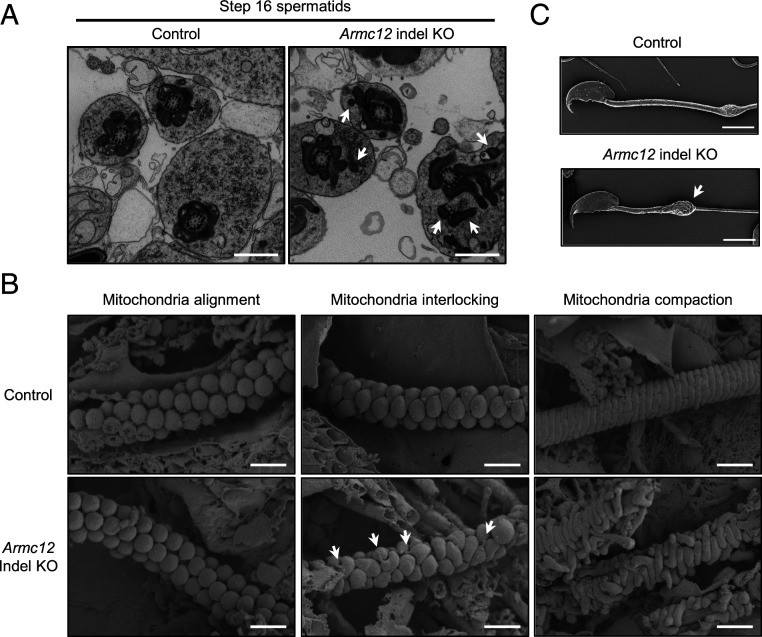
ARMC12 is essential for proper mitochondrial elongation and subsequent coiling along the flagellum during spermiogenesis. (A) Ultrastructural images of step 16 spermatids analyzed by TEM. Arrows indicate aberrant location of sperm mitochondria. (Scale bars, 1.0 μm.) (B) Development of mitochondrial sheath during spermiogenesis observed by SEM. Arrows indicate exposed mitochondrial tips. (Scale bars, 1.0 μm.) (C) Sperm morphology of control and Armc12 indel KO spermatozoa collected from the cauda epididymis. Samples were observed by SEM. Arrow indicates abnormal uncoiled mitochondria that shed from the midpiece. (Scale bars, 5.0 µm.)